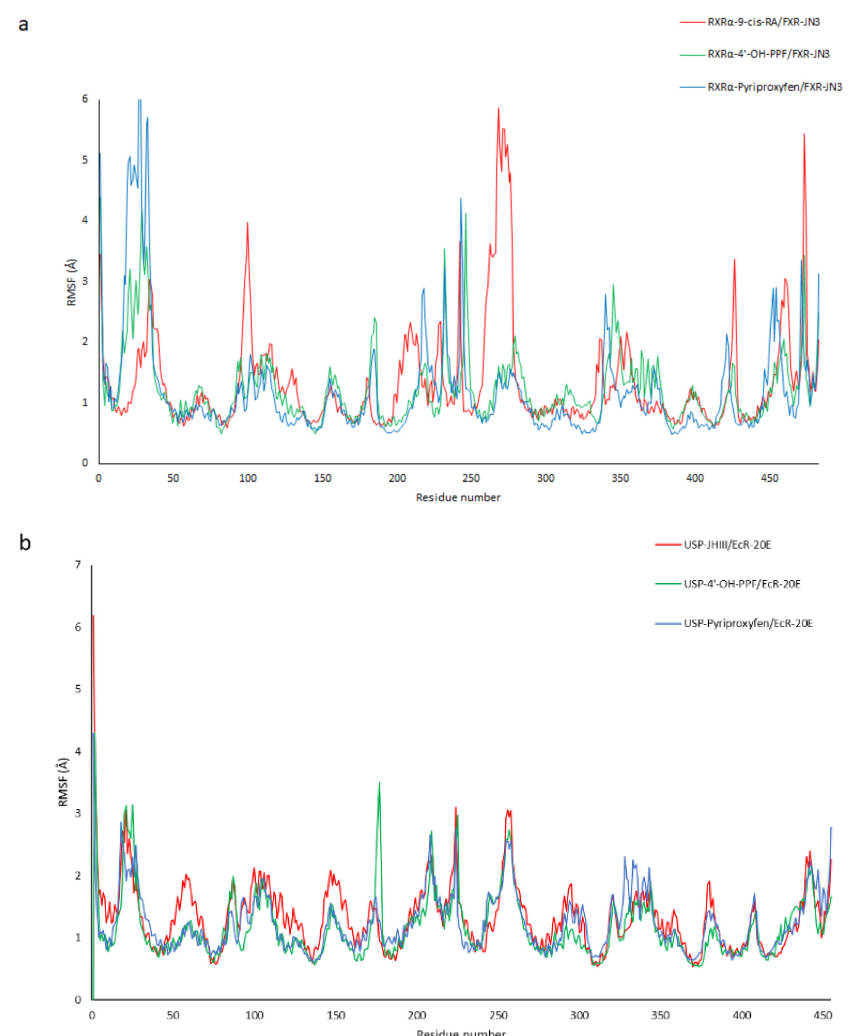
Figure 7. RMSF of the three H. sapiens ( a ) complexes and the three A. mellifera complexes ( b ) obtained by molecular dynamic simulations.